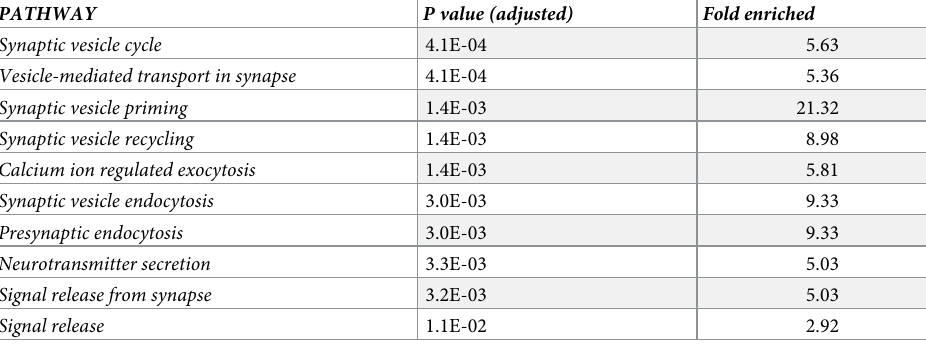
Table 1. Top 10 enriched pathways in the synaptic type of AD.